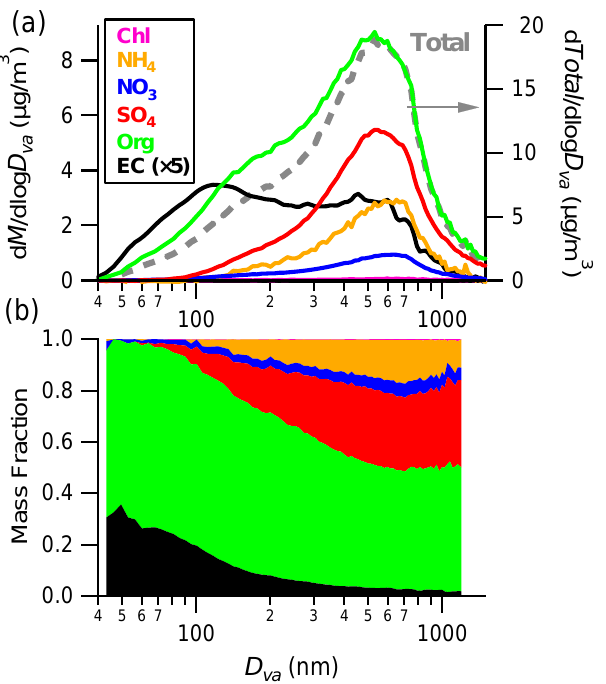
Fig. 6. Average size distributions of (a) mass concentrations and (b) fractional compositions of submicron aerosol species for the en- tire study. The size distribution of EC was estimated based on that of m/z 57 after removing the contribution of C 3 H 5 O +